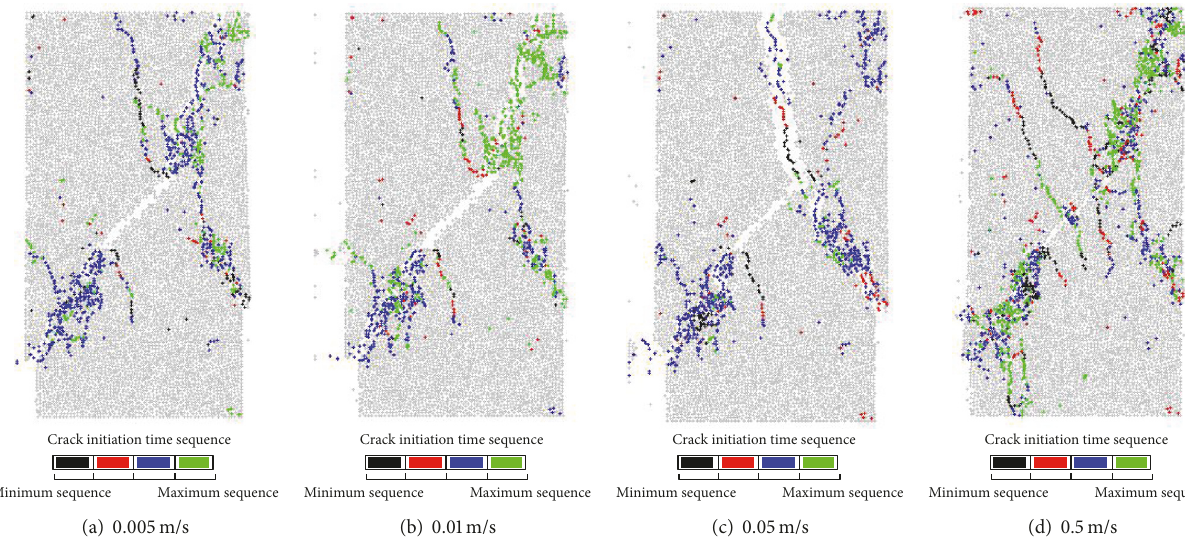
Figure 8: Damage evolution mechanism of fractured rock mass at different loading rates.